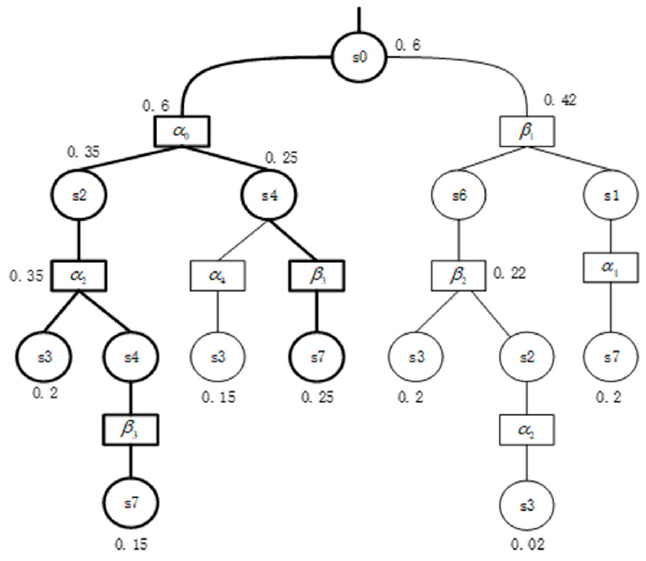
Figure 5. The AND/OR